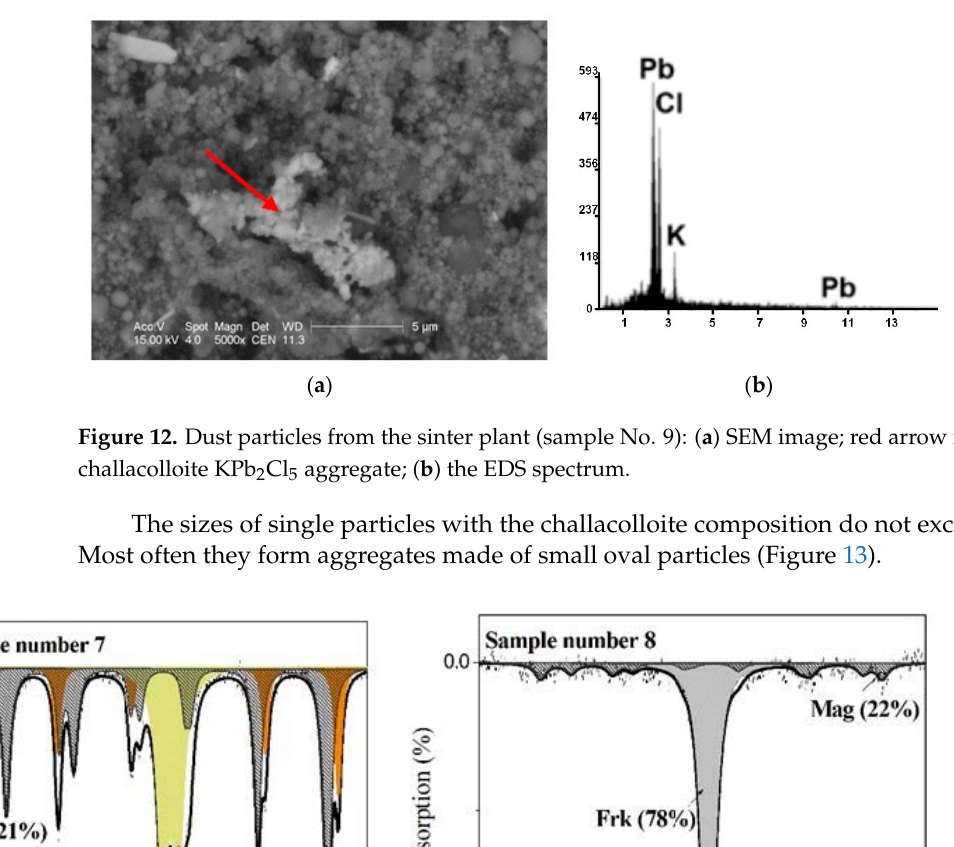
Figure 13. Mössbauer spectra obtained for scale (No. 7) and dedusting dust (No. 8). Fitted subspectra, their assignments and contribution are visible on the spectra; Hem—hematite, Mag—magnetite, Wus—wüstite, Frk—franklinite. Absolute errors are estimated at ± 1% for components areas.